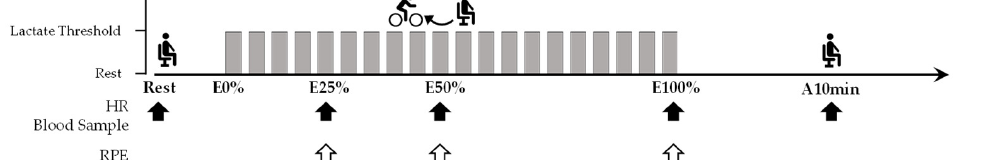
Figure 1. Experimental design: The control (CON) comprised a 20-min period of sitting on a standard chair, continuous exercise (CE) was performed as a 20-min bout of cycling on the cycle ergometer at lactate threshold (LT) intensity, and intermittent exercise (IE) was performed as 20 sets of a one-min bout of cycle ergometer exercise at LT intensity with a 30-s rest between every two sets. HR: heart rate, RPE: Borg rating of perceived exertion. HR measurement and blood sampling were performed 10 min before the onset of cycling (Rest), at the 25%, 50%, and 100% time points of exercise (E25%, E50%, and E100%), and at 10 min after running (A10min), while RPE was at E25%, E50%, and E100%. The closed arrow ( ) and open arrow ( ) indicate the timing of HR measurement and blood sampling and the timing of RPE measurement, respectively.